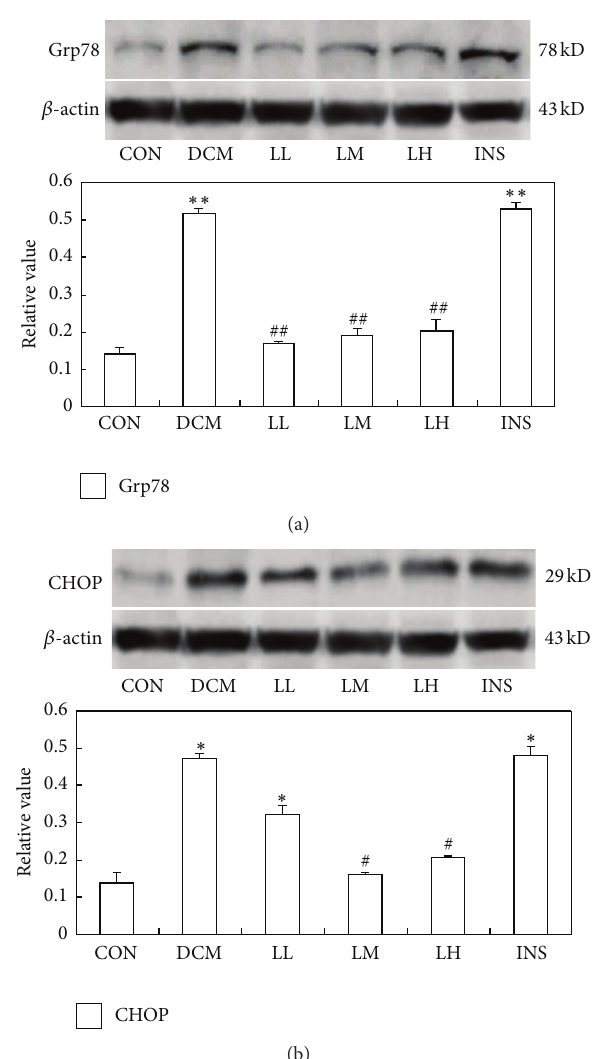
Figure 3: Immunoblot analysis for (a) Grp78 and (b) CHOP in the myocardium of DCM and CON rats. The upper trace of each panel shows representative blots of proteins in DCM and CON rats. The lower panels show the bar graphs summarizing the immunoblot data. Western blot was performed using each relevant antibody. 𝛽 - actin was shown as a loading control. Data were shown as mean ± S.D. ∗ 𝑃 < 0.05 and ∗∗ 𝑃 < 0.01 versus CON rats, # 𝑃 < 0.05 , and ## 𝑃 < 0.01 versus DCM